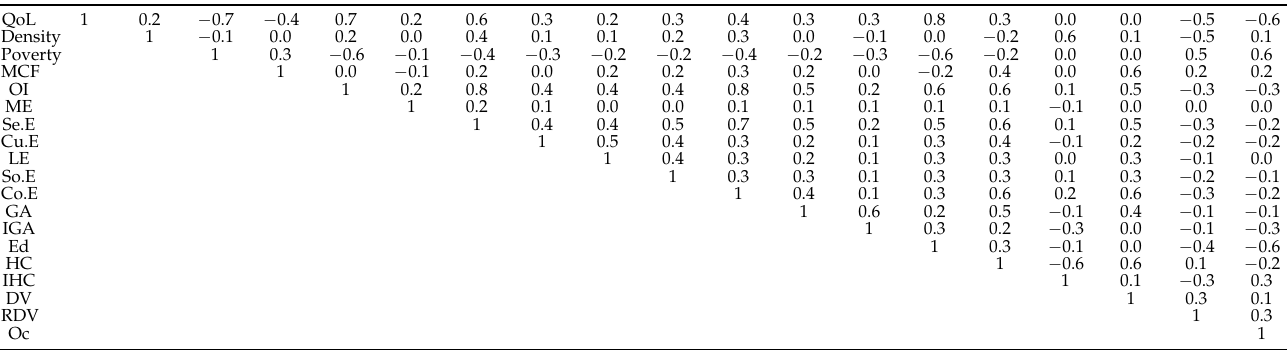
Table 5. Correlations among